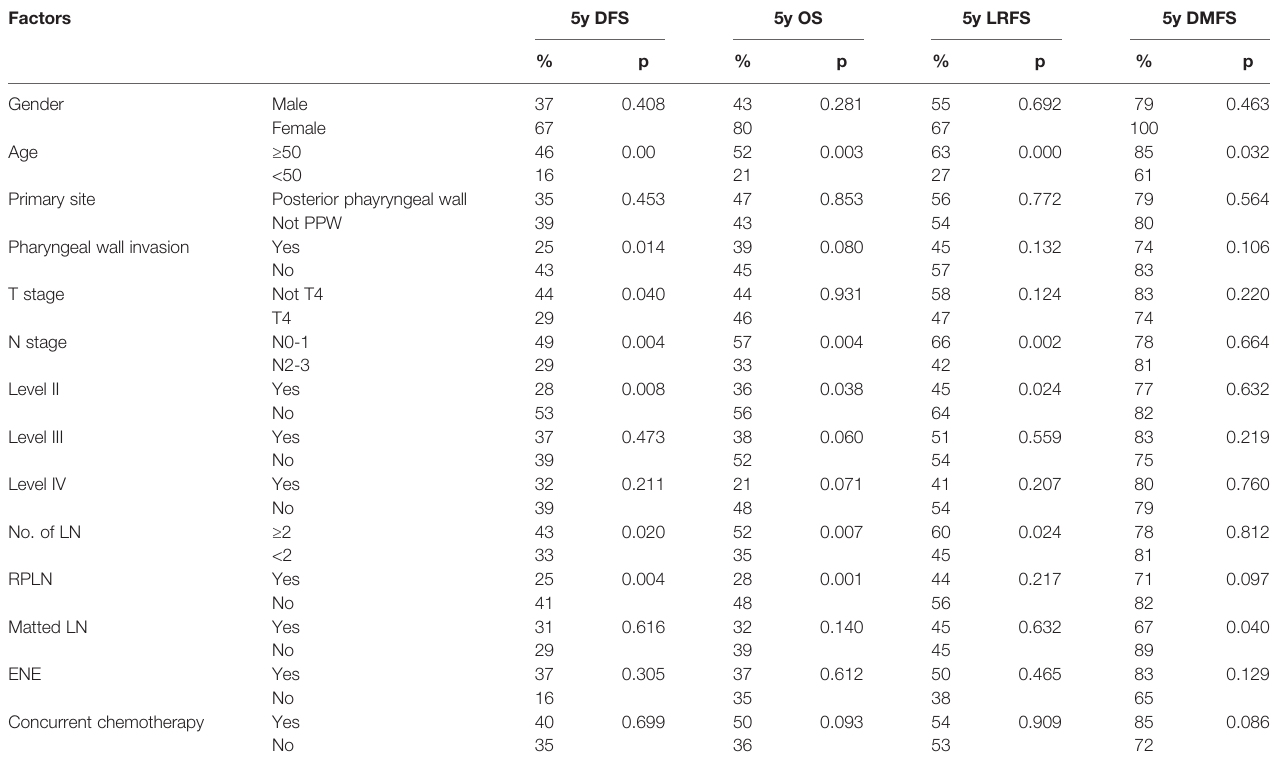
TABLE 3 | Results of univariate analysis in identifying factors associated with LRFS, DMFS, OS and DFS.